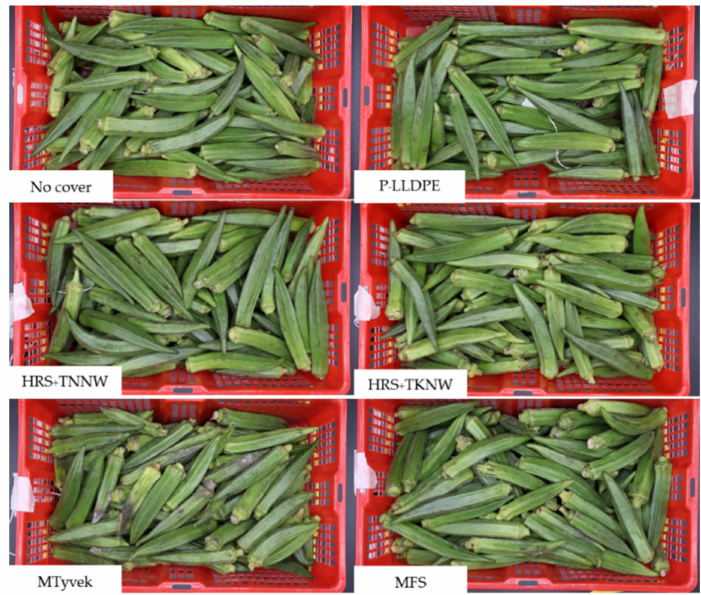
Figure 13. Okra from six treatments after simulated storage at 18 ◦ C for 48 h and simulated trans- portation at 30 ◦ C for 15